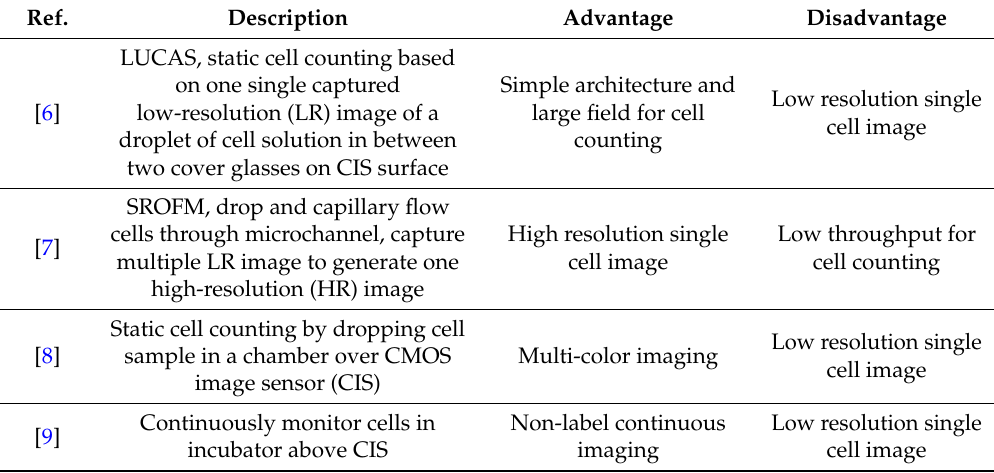
Table 1. Comparison of lensless shadow imaging